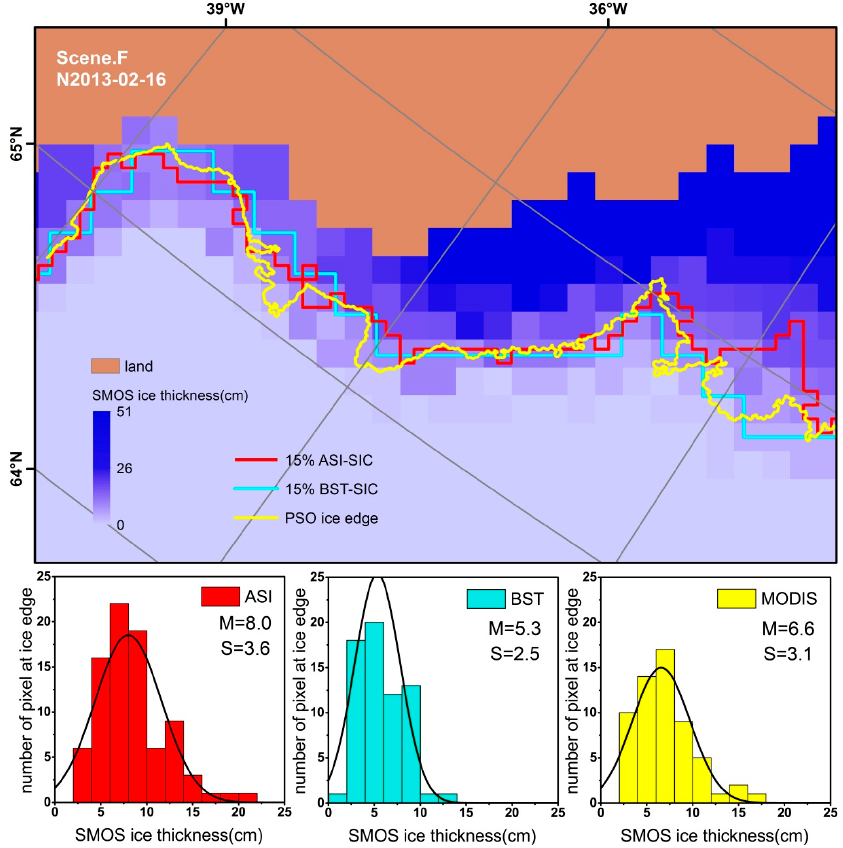
Figure 7. Contour of the 15% ASI ‐ SIC, 15% BST ‐ SIC and the PSO ice edge overlaid on the SMOS ice thickness map, on 16 February 2013.